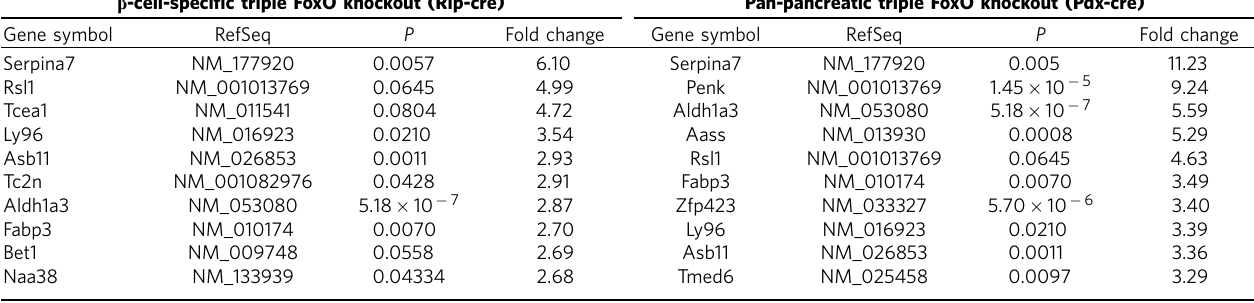
Table 1 | Comparison of the top ten transcripts in two models of Foxo knockout b cells. b -cell-specific triple FoxO knockout (Rip-cre) Pan-pancreatic triple FoxO knockout (Pdx-cre) Gene symbol